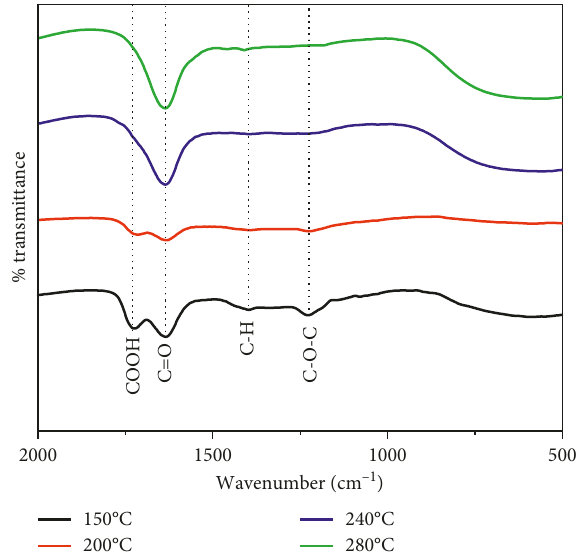
Figure 3: FTIR spectrum of